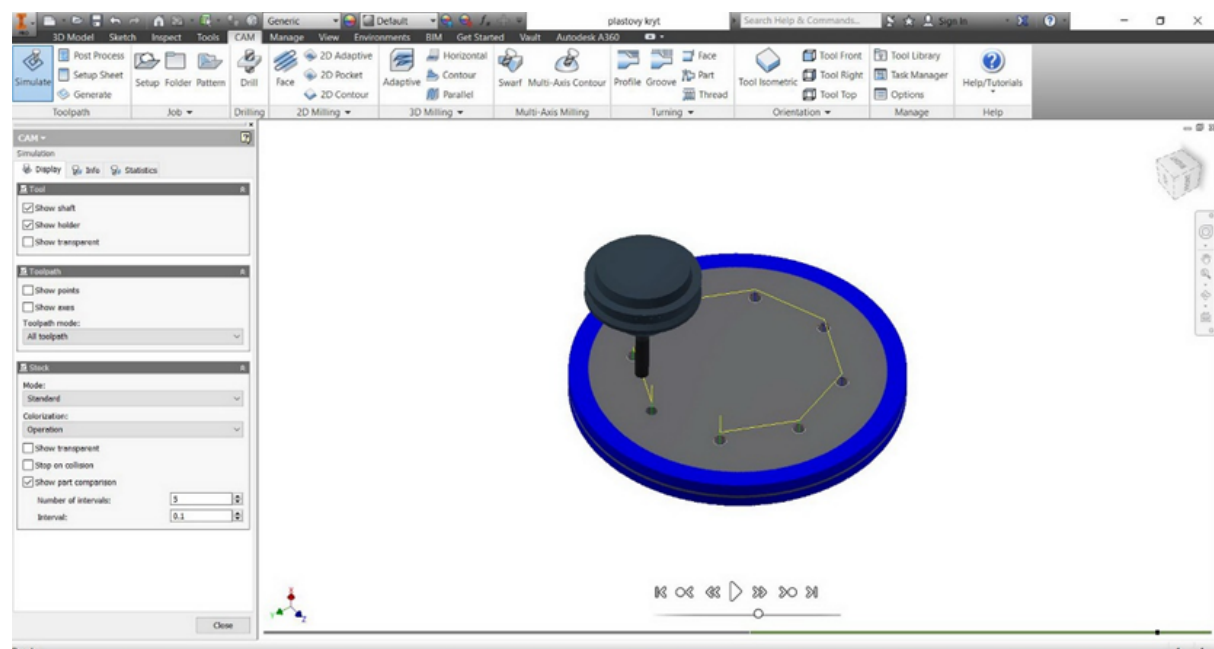
Figure 11: 8 × M6 thread cutting simulation.